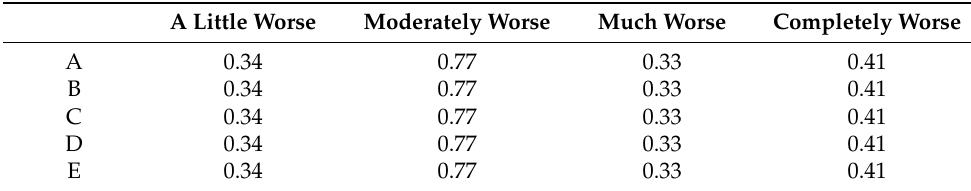
Table 5. Matrix R.